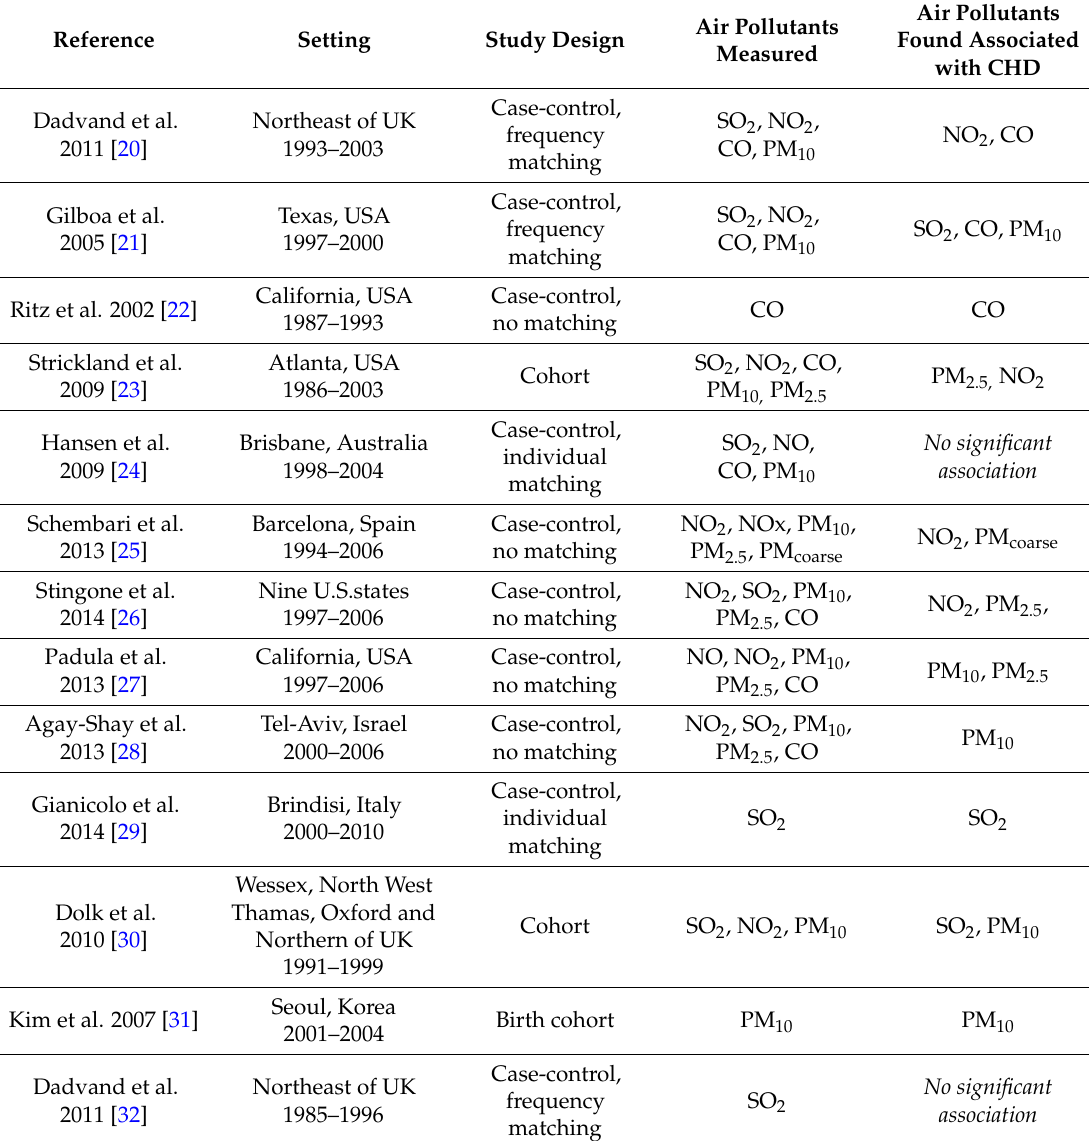
Table 1. Overview of major epidemiological studies analyzing the impact of air pollution on congenital heart disease